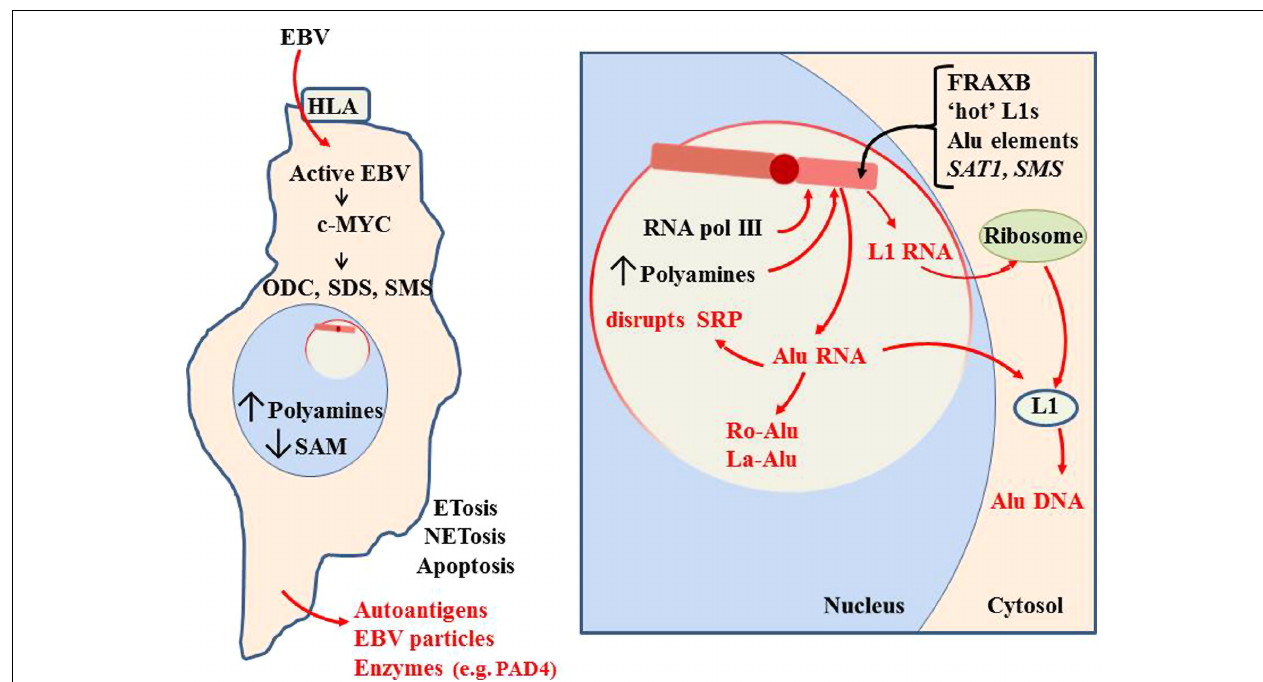
with Ro and La proteins, which aid in processing of RNA pol III transcripts, could incorporate Ro and La into autoantigens. Expression of L1 from the Xi could lead to L1 protein that reverse transcribes Alu RNA to DNA.This Alu DNA would be hypomethylated and could bind Ku and nascent histones in the cytosol.These would be autoantigenic since they are outside their normal epigenetic context.These autoantigens could be released extracellularly through apoptosis, NETosis or ETosis.This can include degradative enzymes, such as peptidylarginine deiminase 4 (PAD4; Brooks,